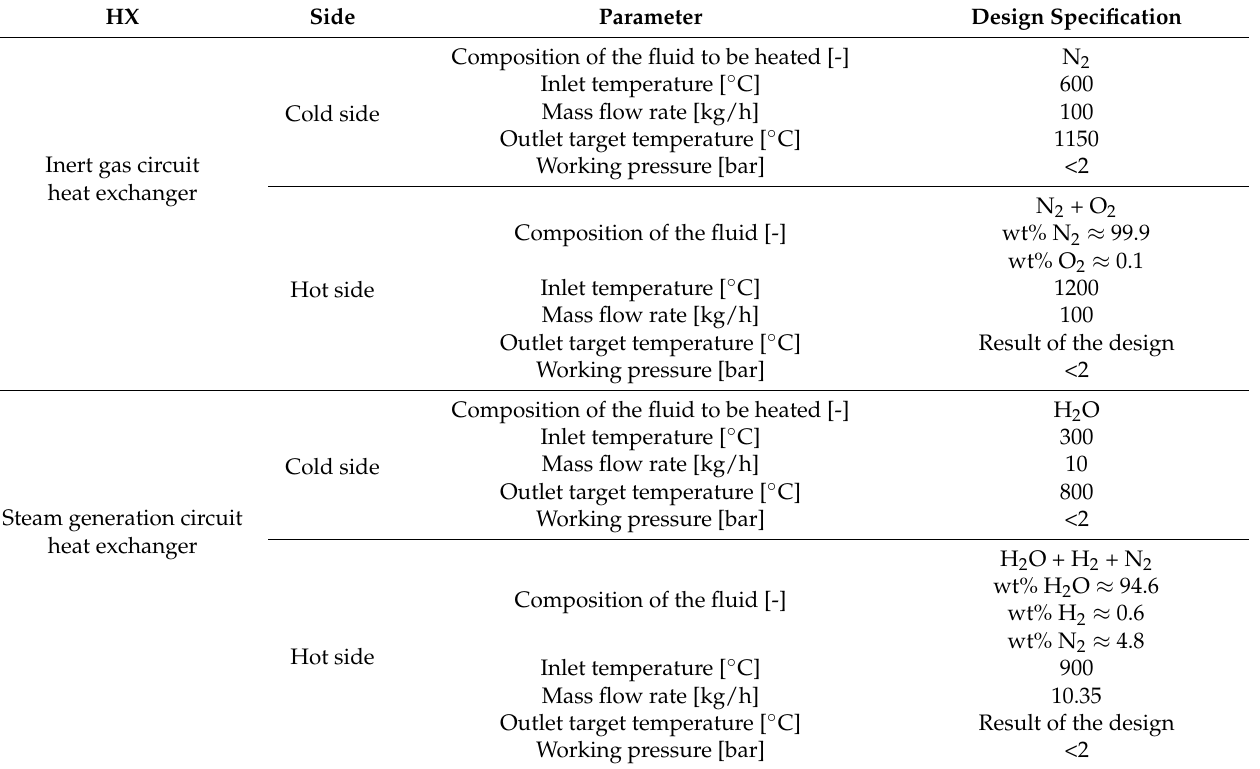
Table 1. Heat exchangers operating conditions of the HYDROSOL-beyond project. HX Side Parameter